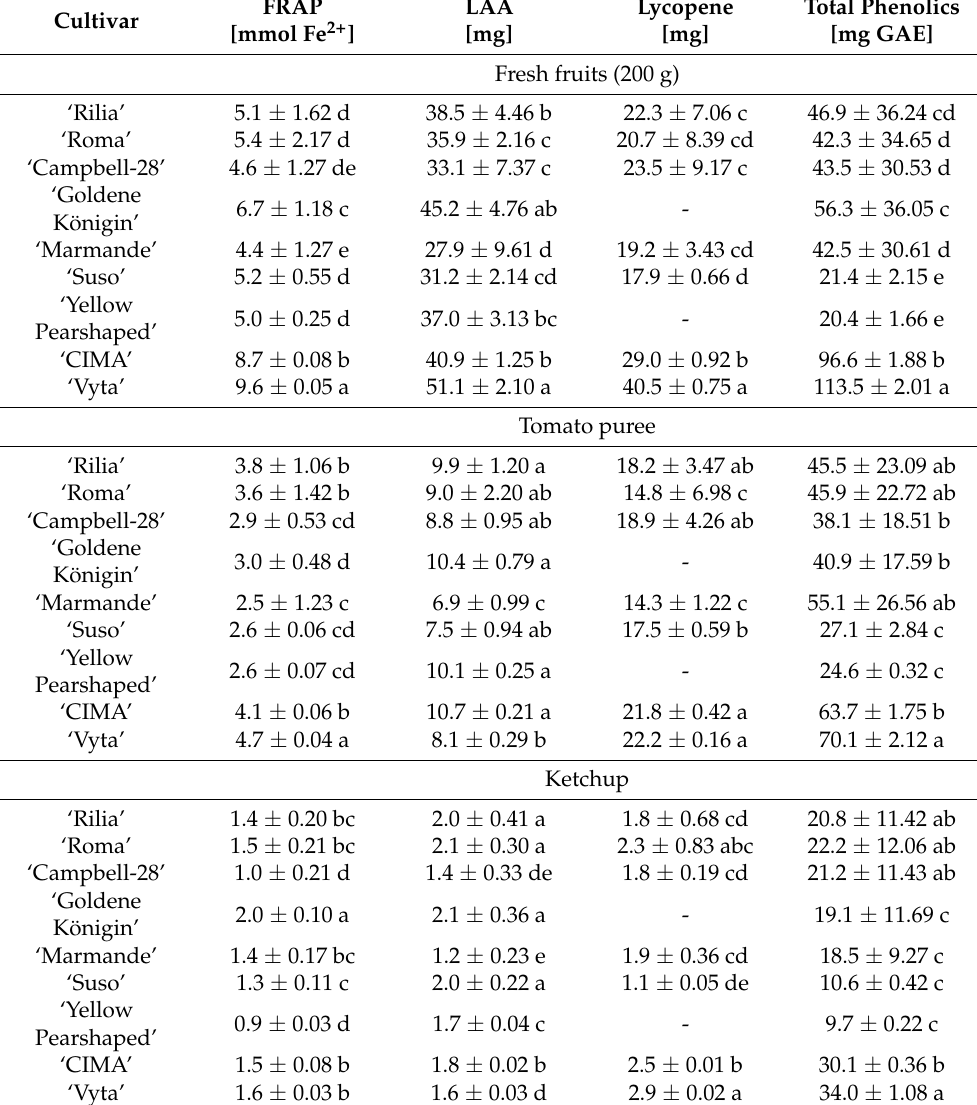
Table 2. Intake of selected bioactive compounds and contribution to antioxidant capacity by serving size as a function of tomato cultivar and processing level. Data are expressed on the basis of serving size: 200 g for fresh tomatoes, 60 mL for puree and 15 mL for